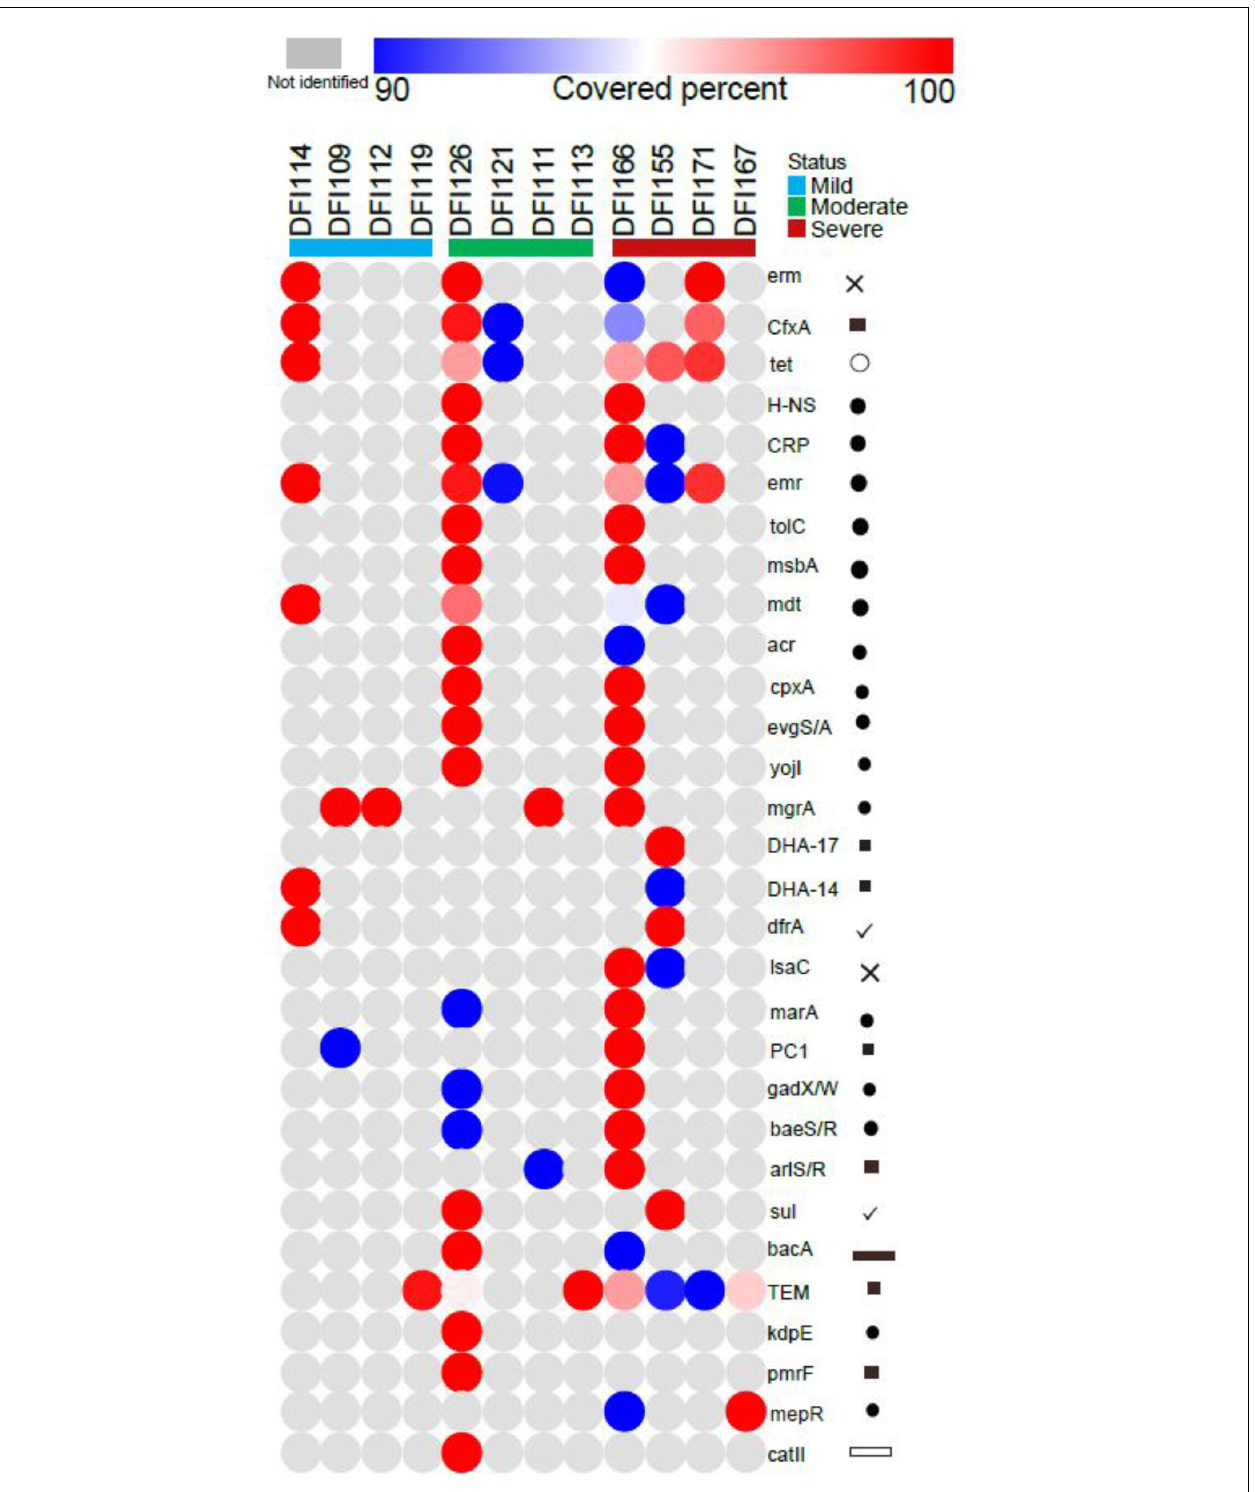
Frontiers in Microbiology |